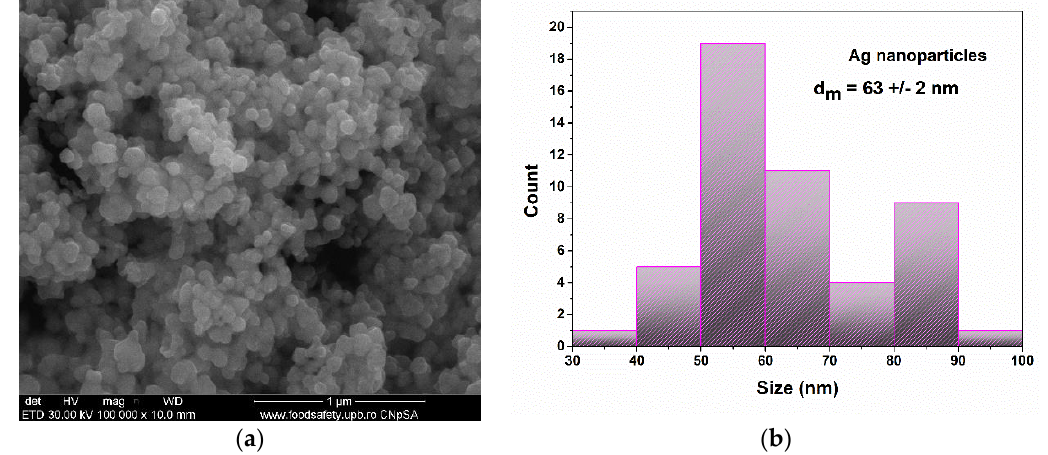
Figure 2. SEM analysis (a) and histogram (b) of the silver nanoparticle powder.